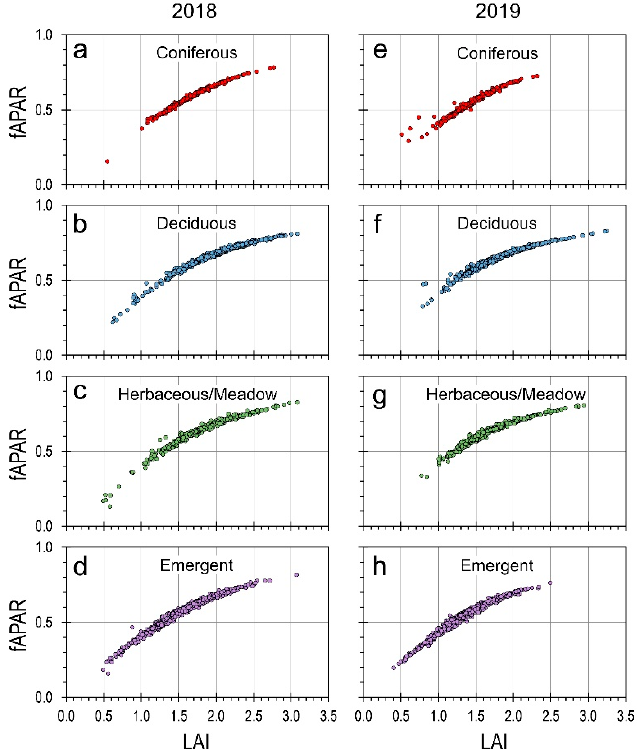
Figure 15. August comparison of fAPAR vs. LAI for the 2018 ( a – d ) and 2019 ( e – h ) for the Coniferous, Deciduous, Herbaceous/Meadow and Emergent classes. See Figure 13 for definition of acronyms.